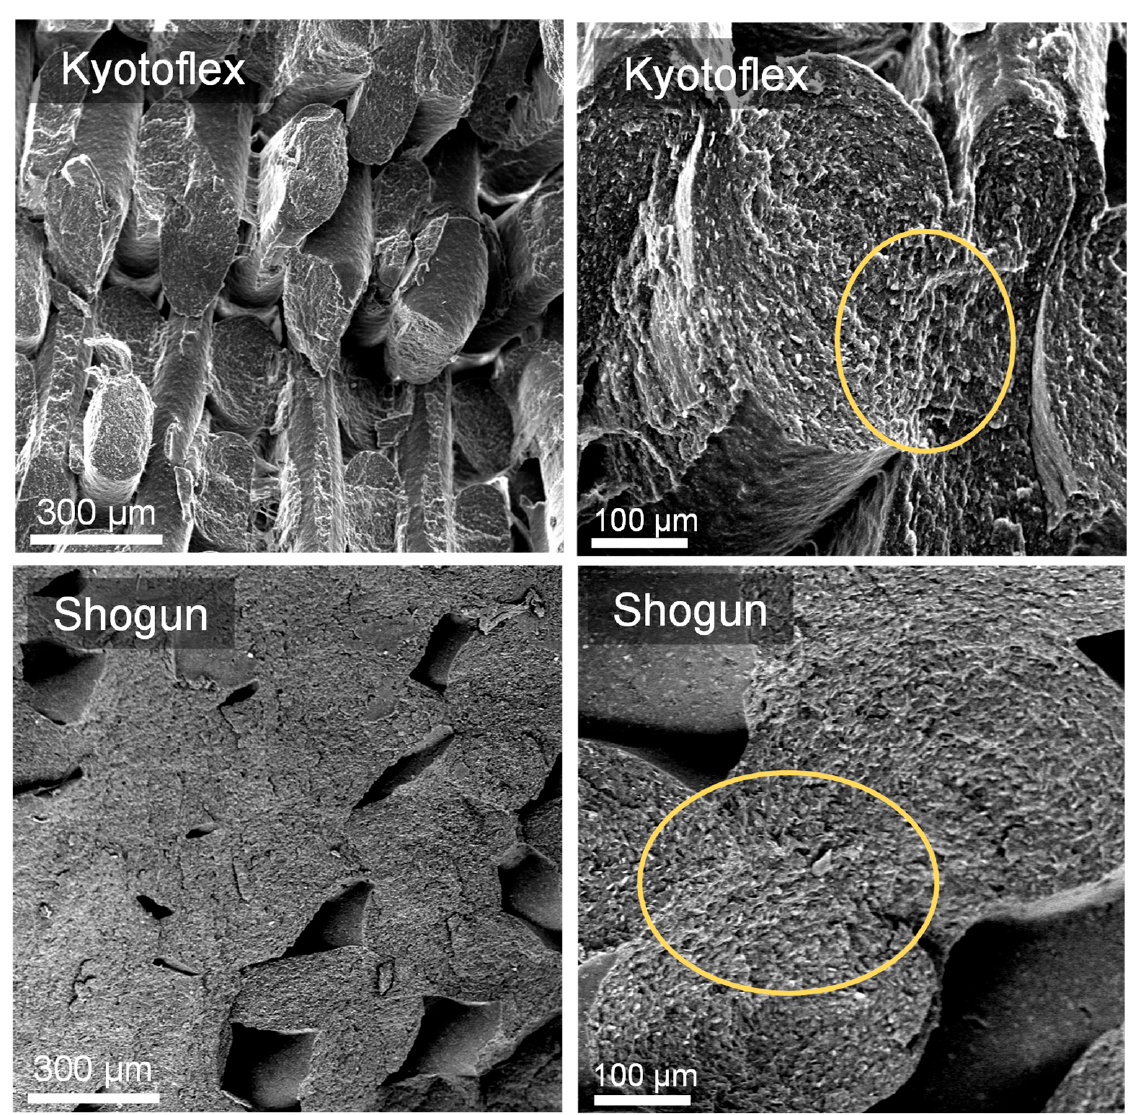
Figure 8. Representative SEM micrographs at different magnifications of selected 3D-printed